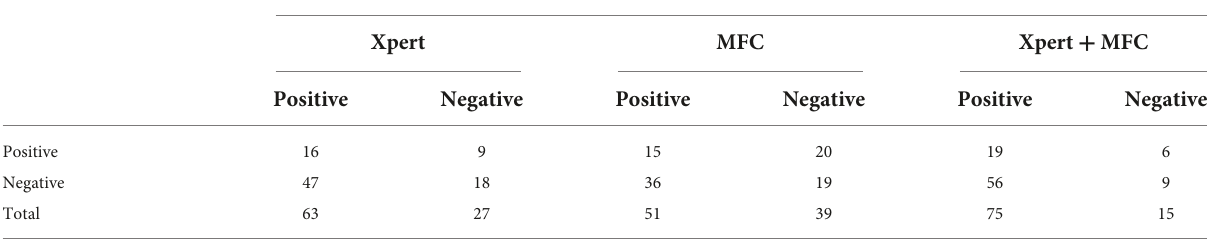
TABLE 5 Diagnosis of pulmonary tuberculosis by core needle biopsy and aspiration biopsy ( n = 90). Core needle biopsy